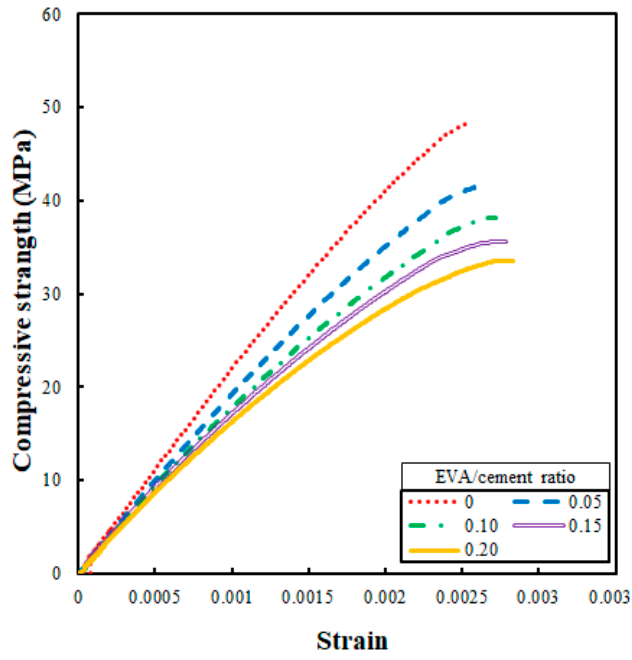
Figure 8. Stress–strain diagrams for different EVA/cement ratios.